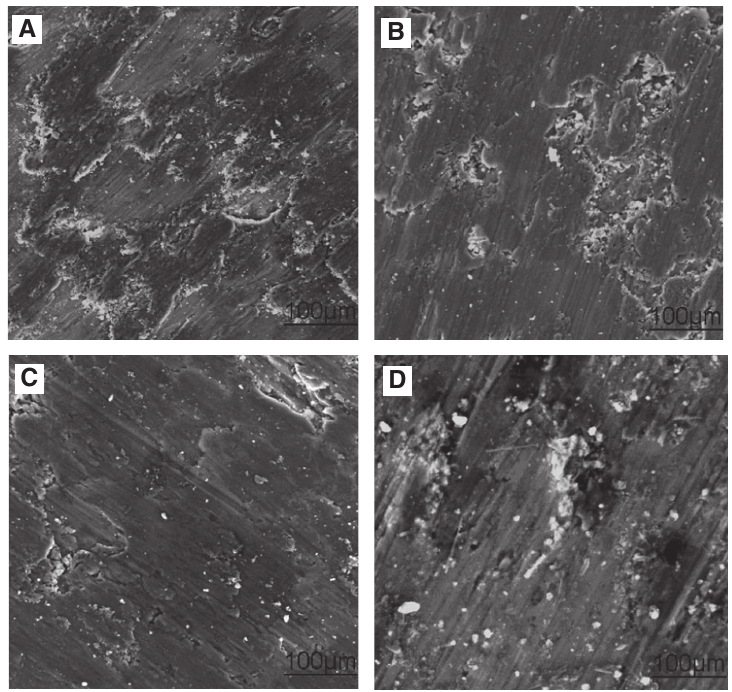
-CB materials with different CB content: (A) 0%, (B) 5%, (C) 10%, and (D) 15%. Figure 10 Worn surfaces of TiAl 3